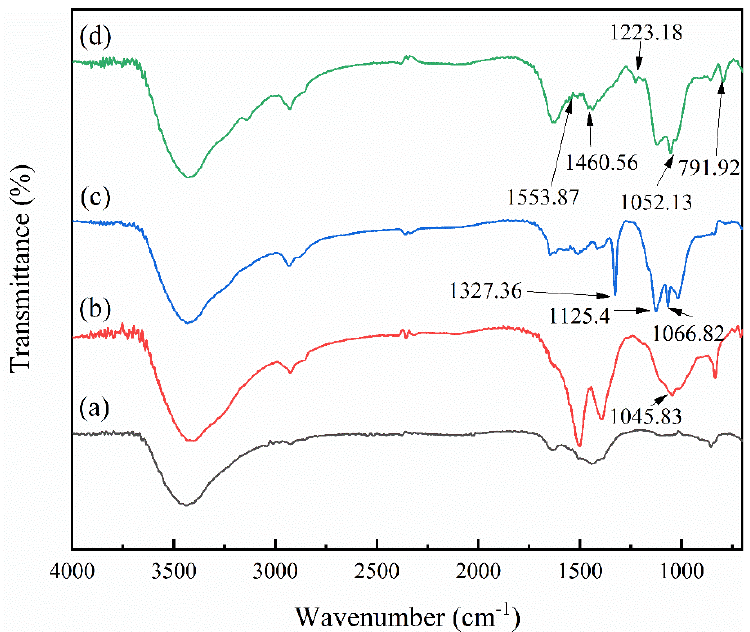
Figure 2. The FT − IR spectrum of ( a ) ZnO; ( b ) ZnO − APTES; ( c ) ZnO − APTES − F; ( d ) ZnO − APTES −